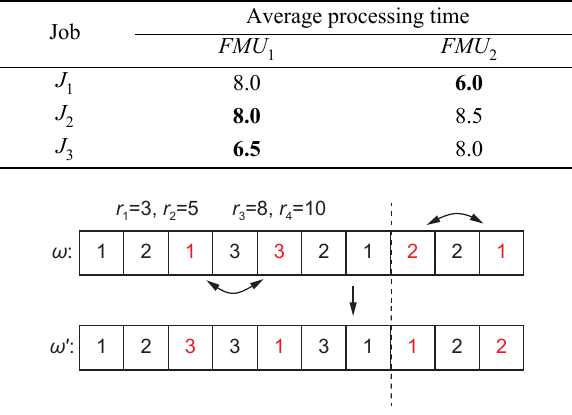
Table 3 Average processing time of each job in each FMU.